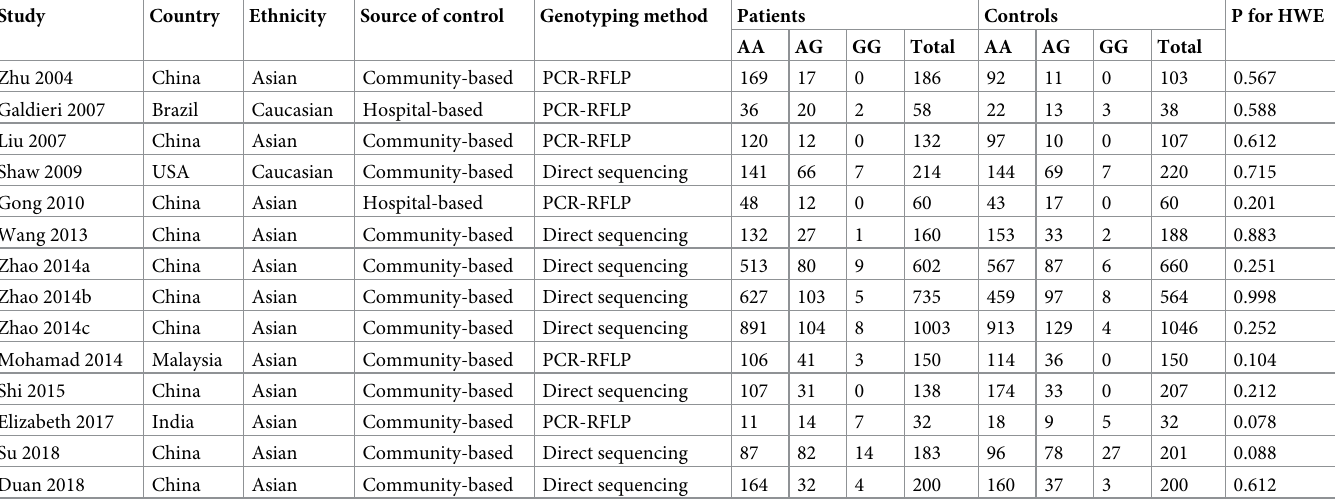
Table 1. Characteristics and genotype status of MTR A2756G in patients and controls for the included studies.